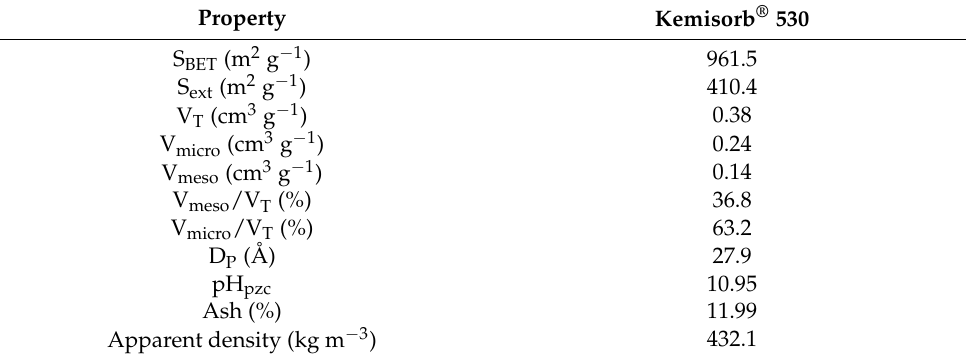
Table 3. Textural and chemical surface properties of GAC Kemisorb ®